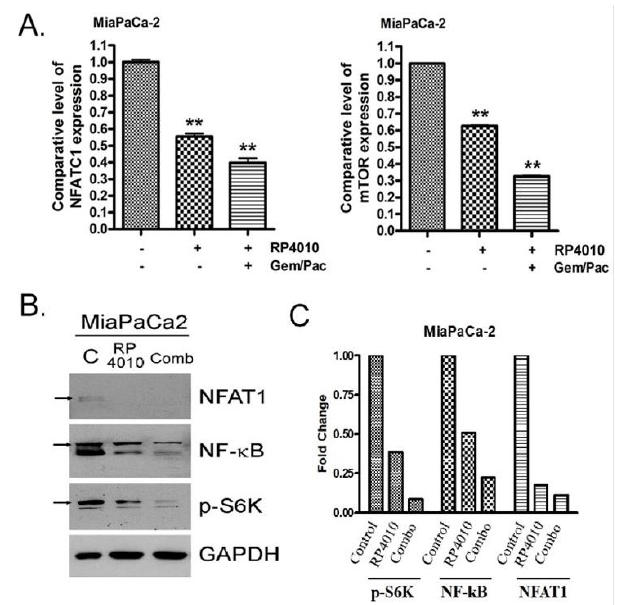
Figure 5. The synergistic effects on the inhibition of cell proliferation by RP4010 and gemcitabine/nab- paclitaxel are mediated through the downregulation of mTOR and NFAT/NF-κB signaling. ( A ) MiaPaCa-2 cells were treated with either 10 µM RP4010 alone or in combination with 300 nM gemcitabine and 3 nM nab-paclitaxel. After 48 h, RNA was isolated and RT-qPCR was performed as described in Methods (** p < 0.01). ( B ) MiaPaCa-2 cells were grown overnight in 100-mm petri